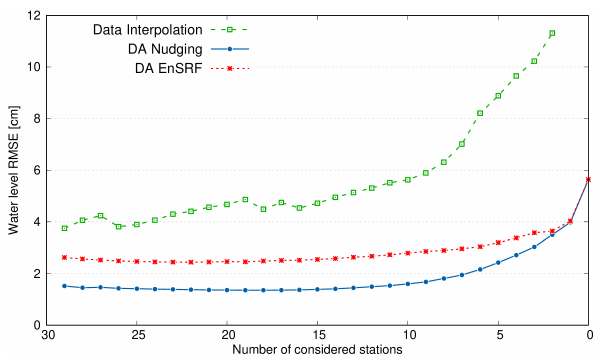
Figure 6. Root mean square error of the water levels as a function of the number of tide gauge stations interpolated or assimilated. The RMSE value with zero considered stations for DA also indicates the error of the base simulation when no DA methods are